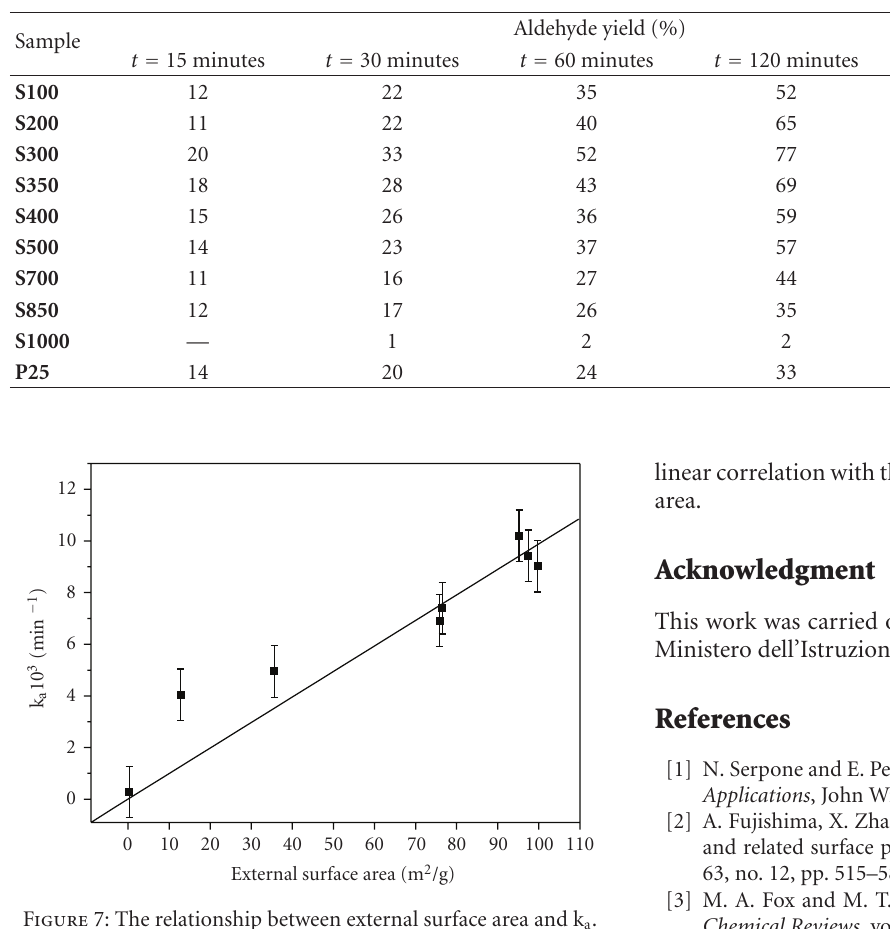
Figure 7: The relationship between external surface area and k a